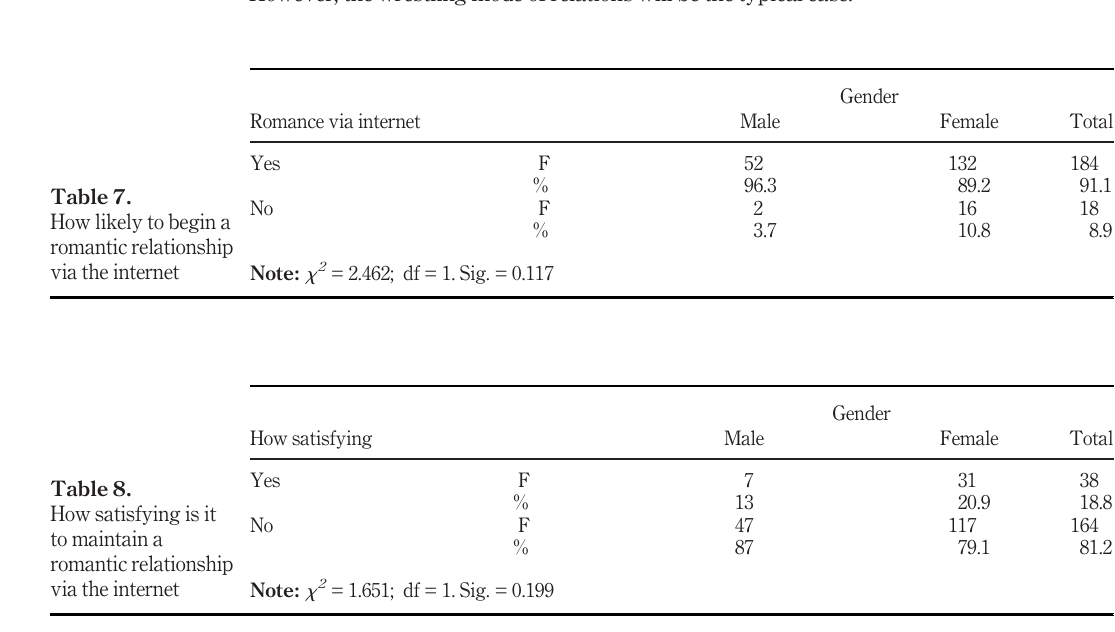
Romance via internet